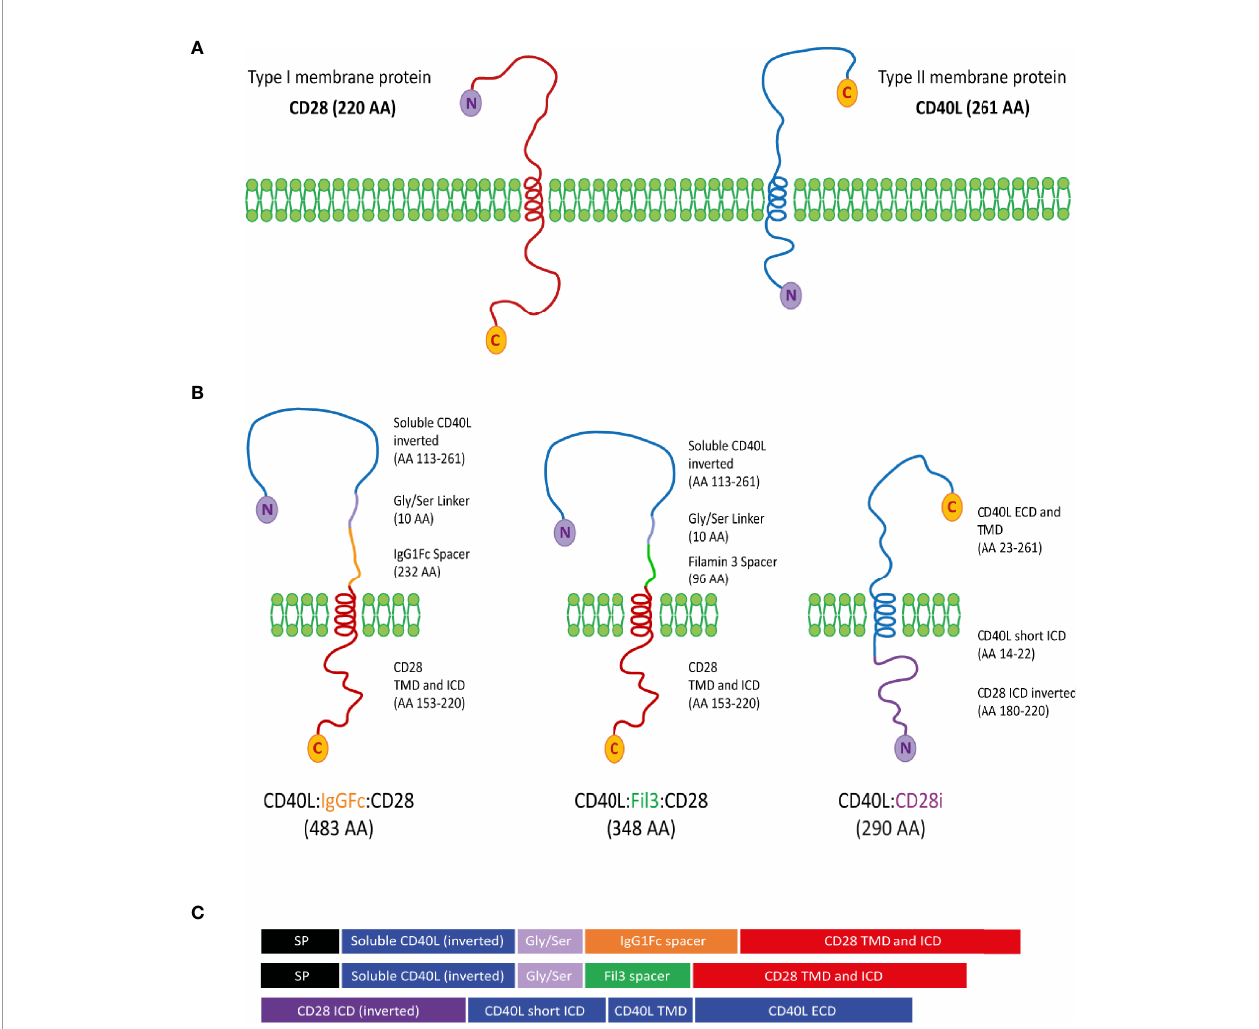
FIGURE 2 | Design of CD40L:CD28 CSPs. (A) CD28 and CD40L are depicted according to their classi fi cation as type I and type II membrane proteins, respectively. C-terminal amino acid (C) and N-terminal amino acid (N) determines the membrane orientation. (B) Schematic representation of the three different approaches for the structure of the CD40L:CD28 CSPs, AA length and origin of protein fragments are speci fi ed next to each molecule. (C) Domain representation of the CSPs including the signal peptide (SP) from the PD-1 protein for type I membrane protein approaches. SP, signal peptide from PD-1 (20 AA); ICD, intracellular domain; TMD, Transmembrane domain; ECD, extracellular